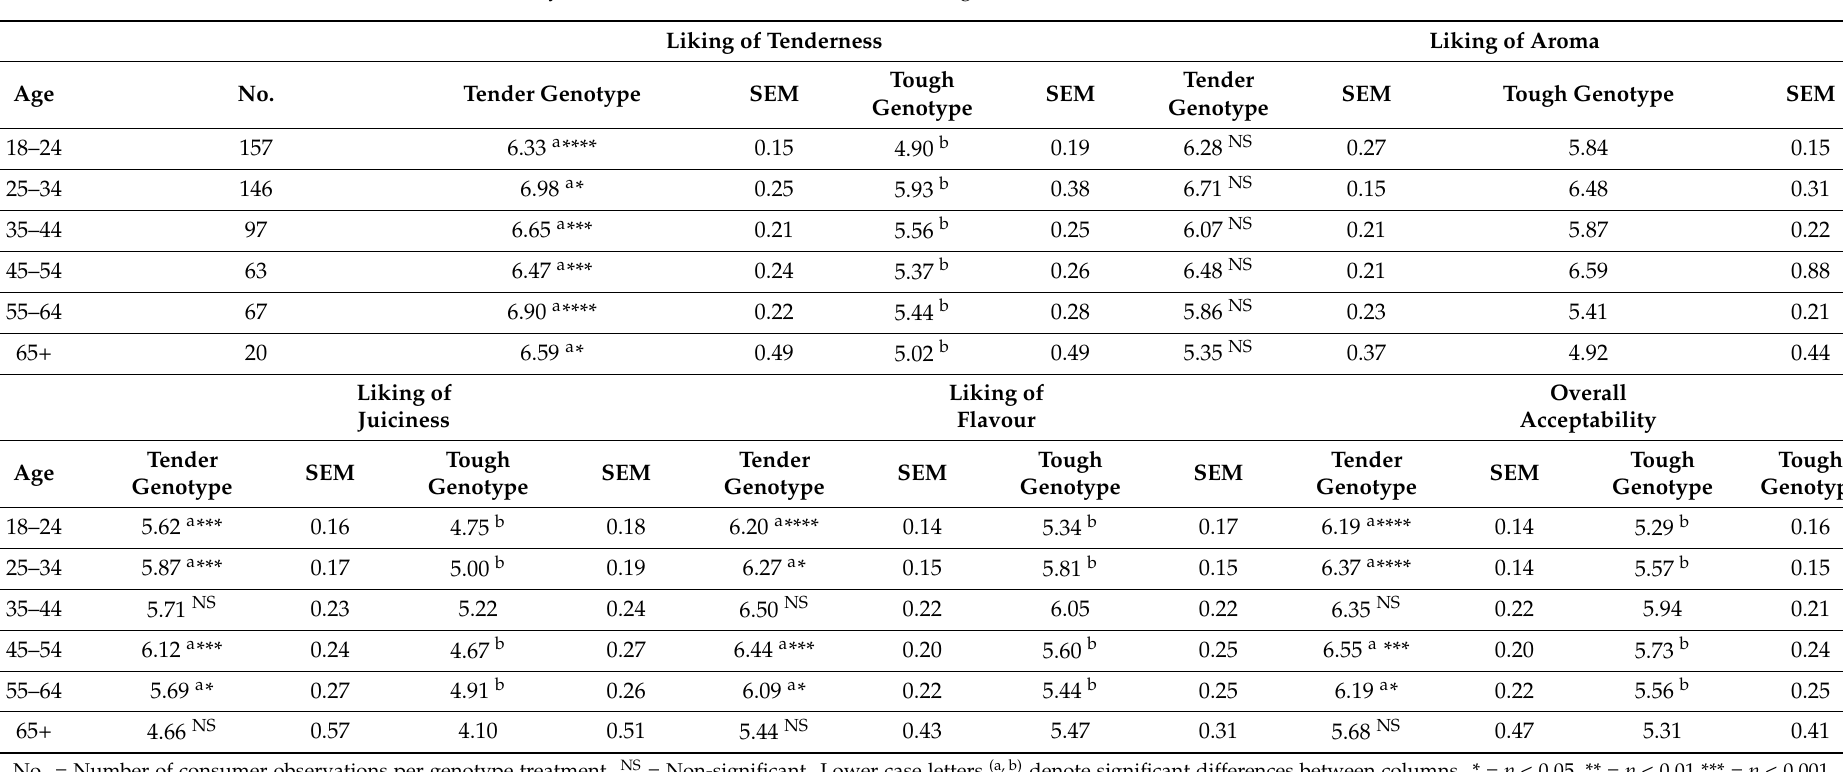
Table 1. Sensory hedonic mean data for each consumer age cohort with standard error of the mean (SEM). Liking of Tenderness Liking of